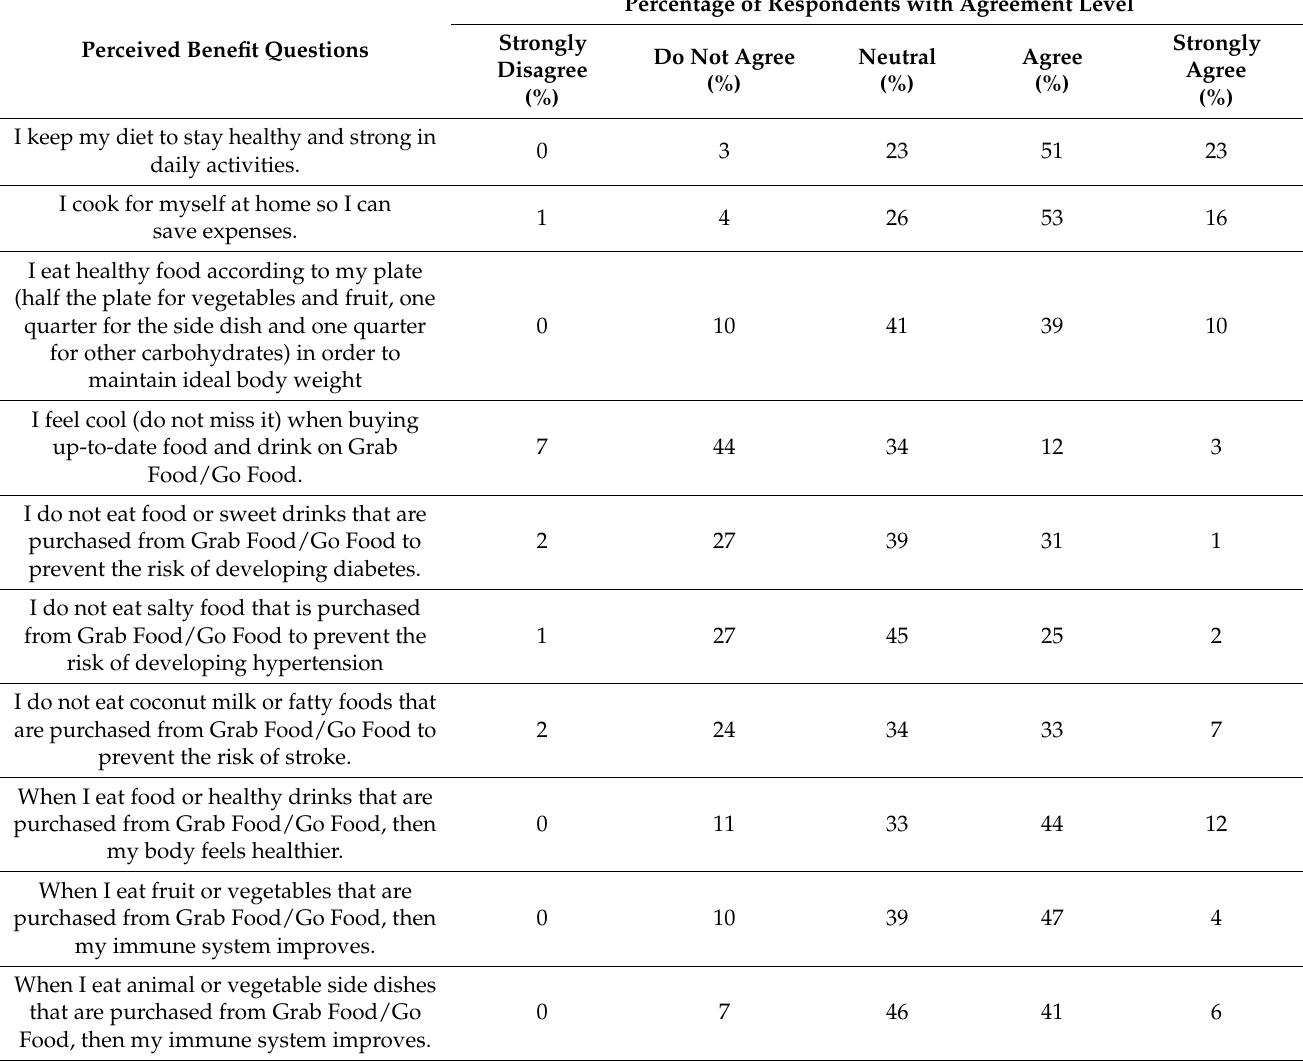
Table 6. Perceived benefit